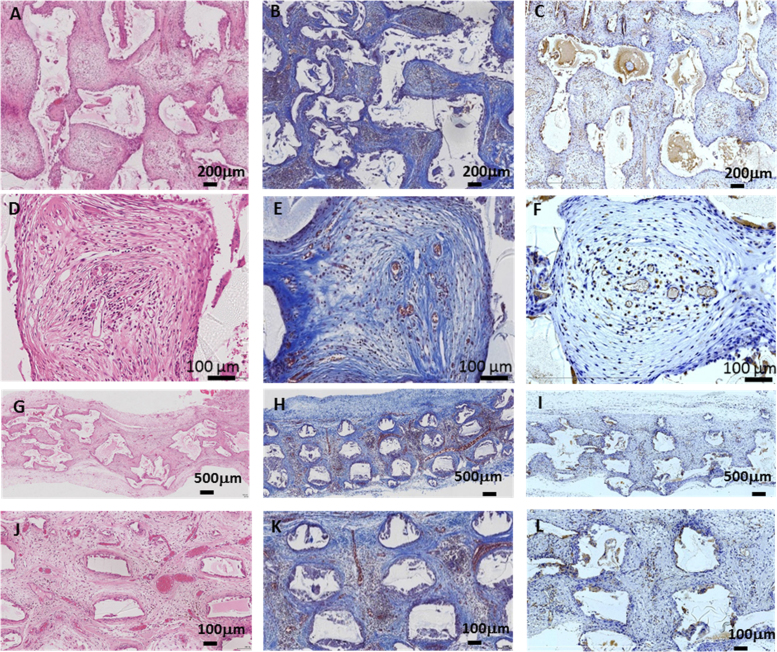
Subcutaneous implantation of 50CC+H scaffolds at week 12: (A) tissue integration of middle-in-plane of the 50CC+H scaffold by Hematoxylin and Eosin (H&E) staining, (B) collagen production by Masson׳s trichrome staining (M&T), (C) endothelial cell infiltration as identified by CD31 staining, used as a marker of angiogenesis; (D-F) enlarged views of middle-in-plane sections respectively. (G-I) Middle cross-sectional view and (J-L) enlarged middle cross-sectional view.